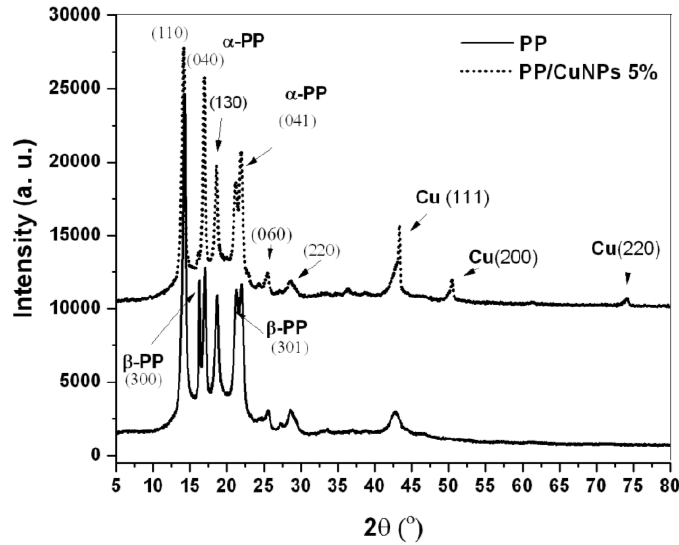
Figure 1. Diffractograms of iPP and PP/CuNPs 5 wt % composite.